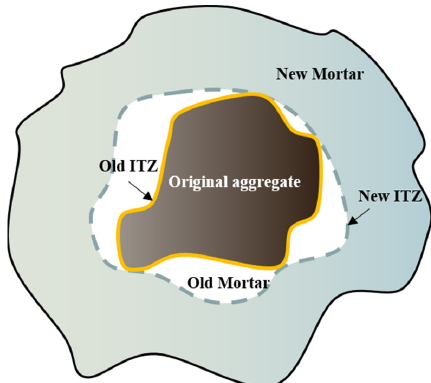
Figure 1. Interfaces of RCA.